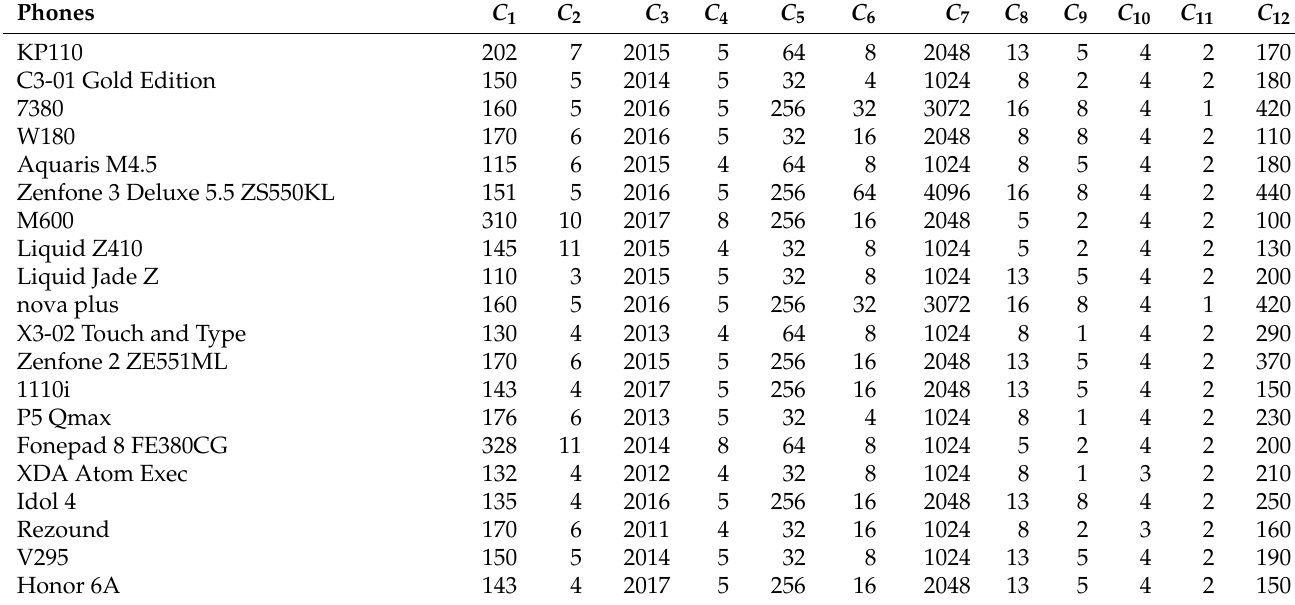
Table 4. Decision matrix for a small set of alternatives.